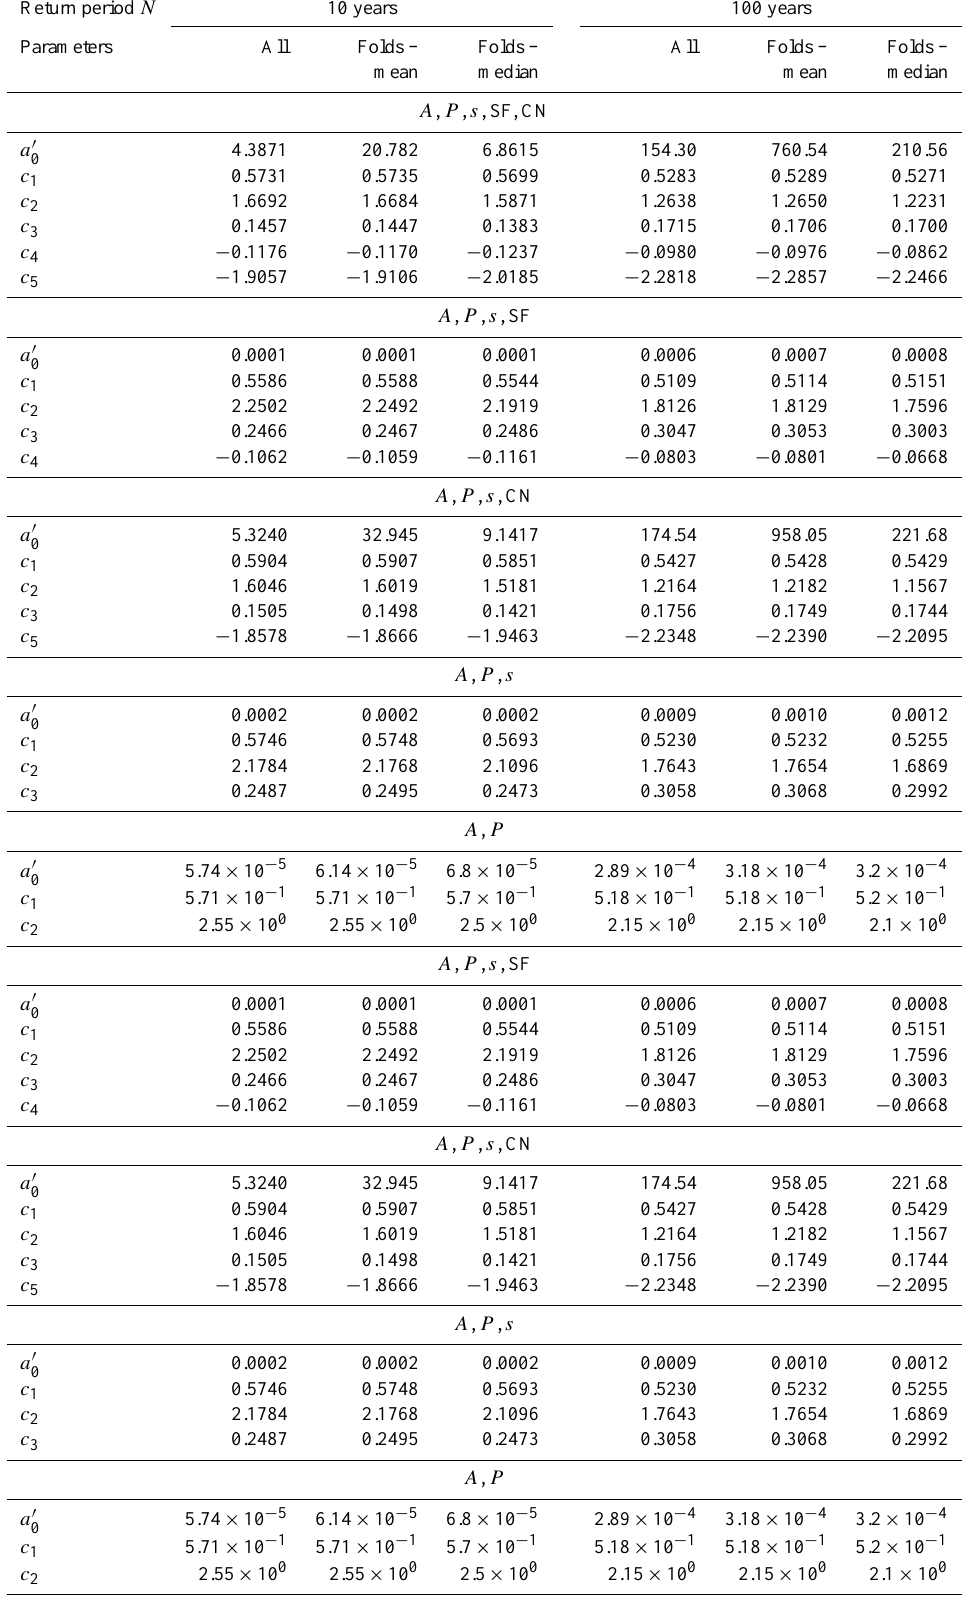
Table 3. Values of calibrated model